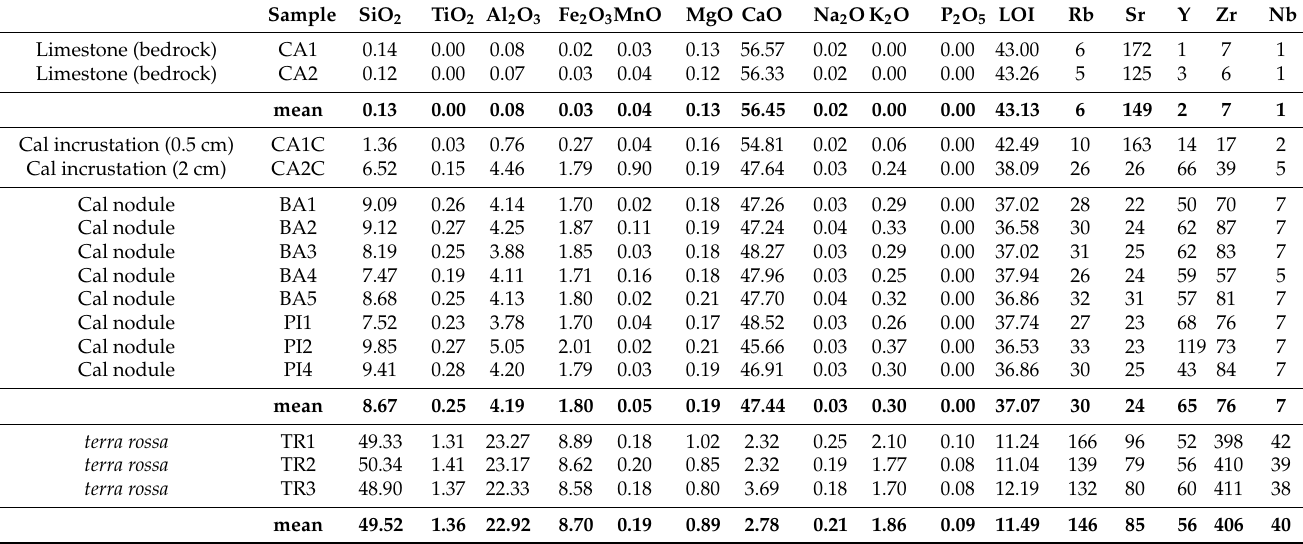
Table 1. Major and trace element composition of the studied samples (XRF